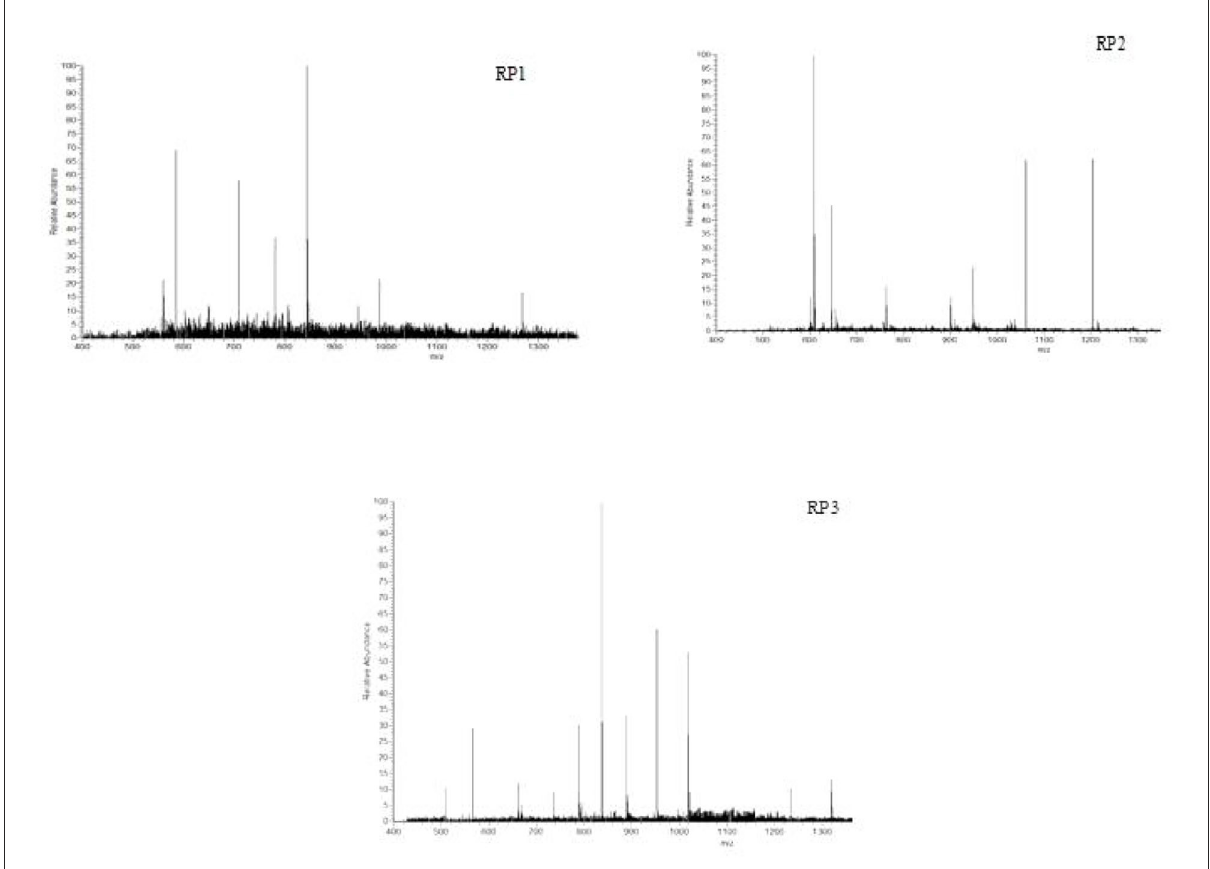
FIGURE8 First-order structure mass spectrum of PSKB antioxidant